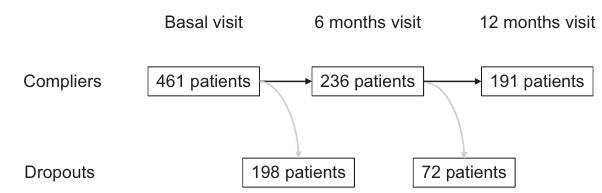
Fig. 1 Flowchart of the participants of the study. The number of patients included at each phase of the evaluation period (Com- pliers), as well as of patients who did not attend (Dropouts) is